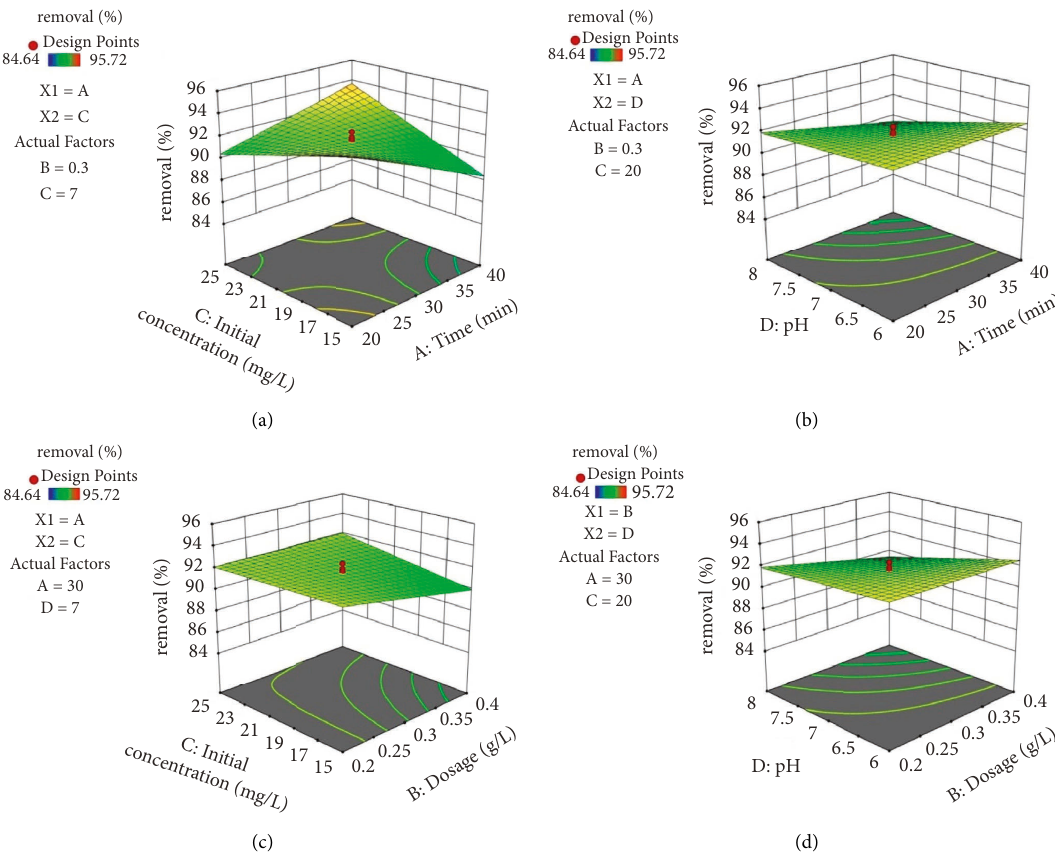
Figure 4: 3D response surface plots for adsorption: (a) time vs. initial concentration, (b) time vs. pH, (c) concentration vs. dosage, and (d) pH vs.